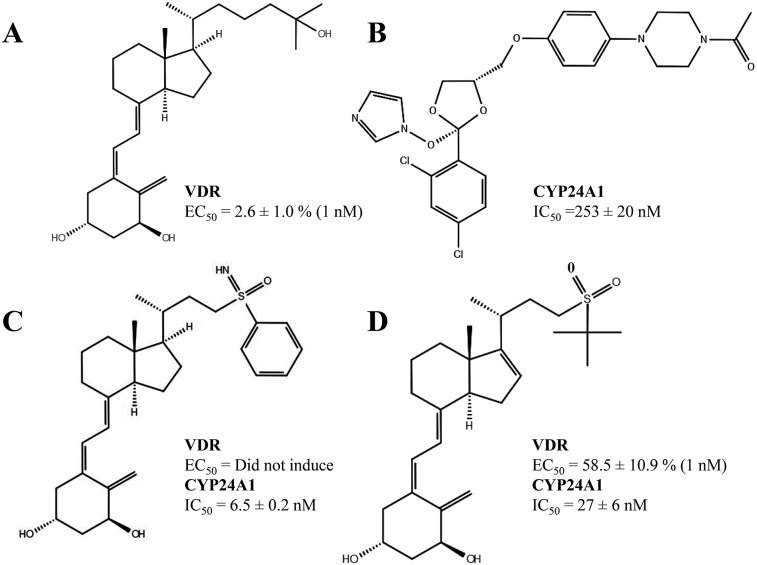
The 2D diagram of the drug molecules (A) 1α25(OH)2D3,(B) ketoconazole,(C) CTA-091 and (D) CTA-018 used in this study and their corresponding EC50 against VDR and IC50 against CYP24A1.